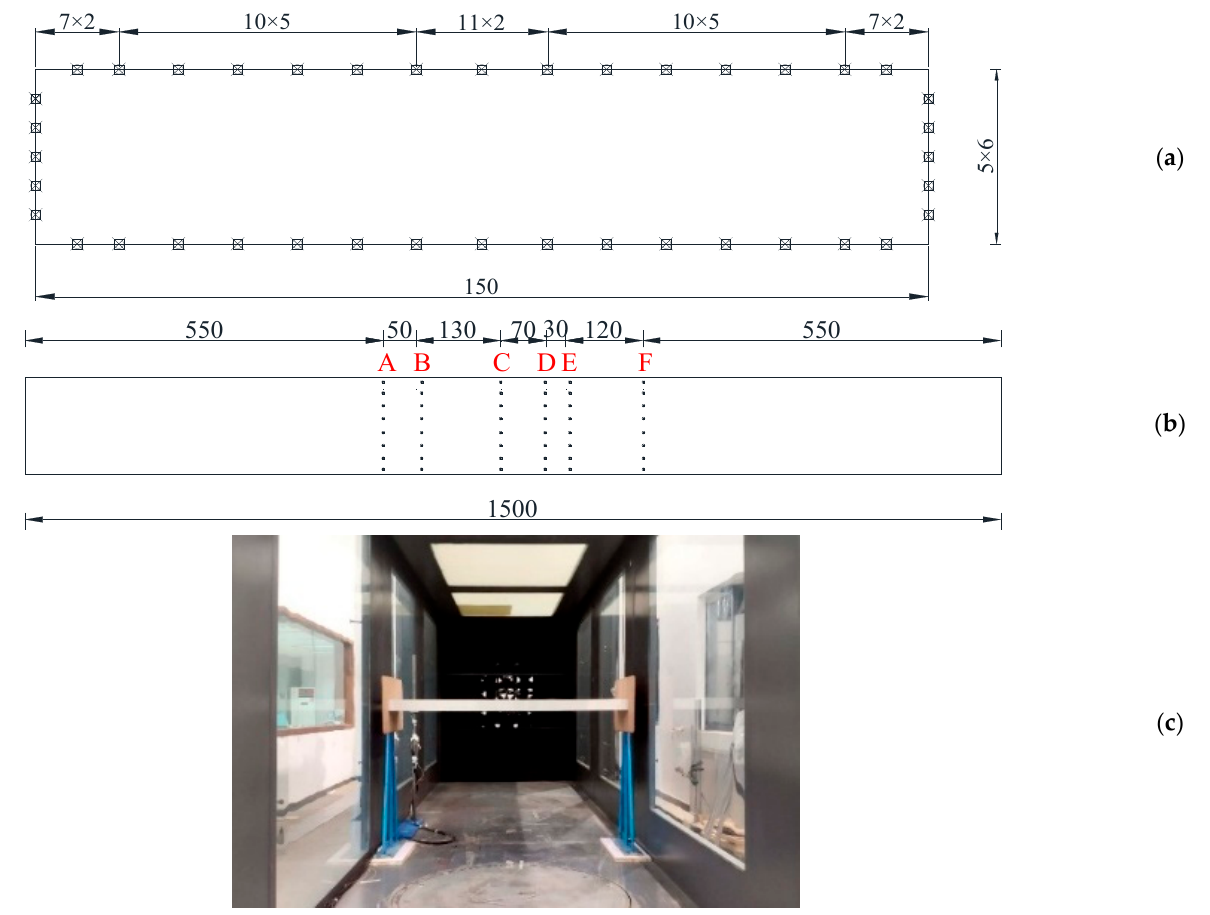
Figure 2. ( a , b ) The rectangular model and the pressure taps (cross-section and plan view, unit: mm); ( c ) the tested model in the wind tunnel.